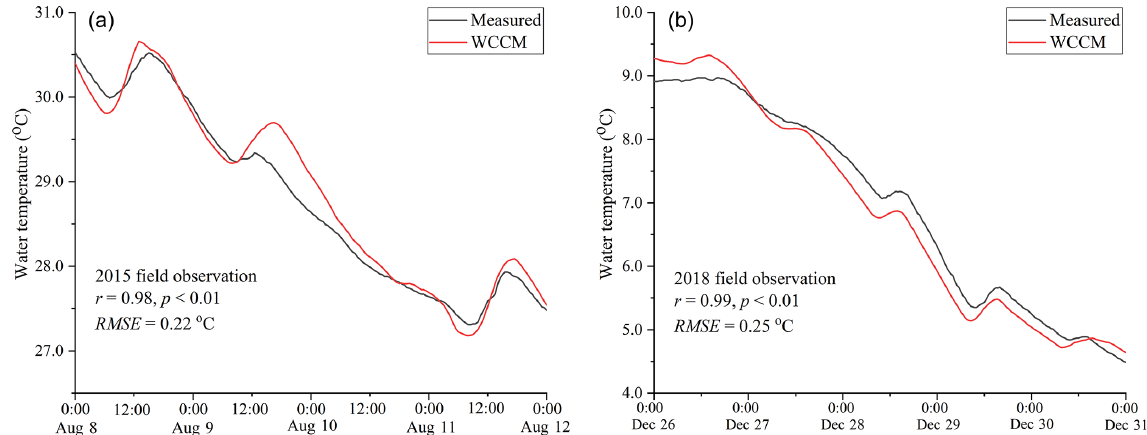
Figure B2. Correlation coefficient (r) and mean absolute error (RMSE) between measured and WCCM-simulated water temperature at the LHWS during the 2015 and 2018 field